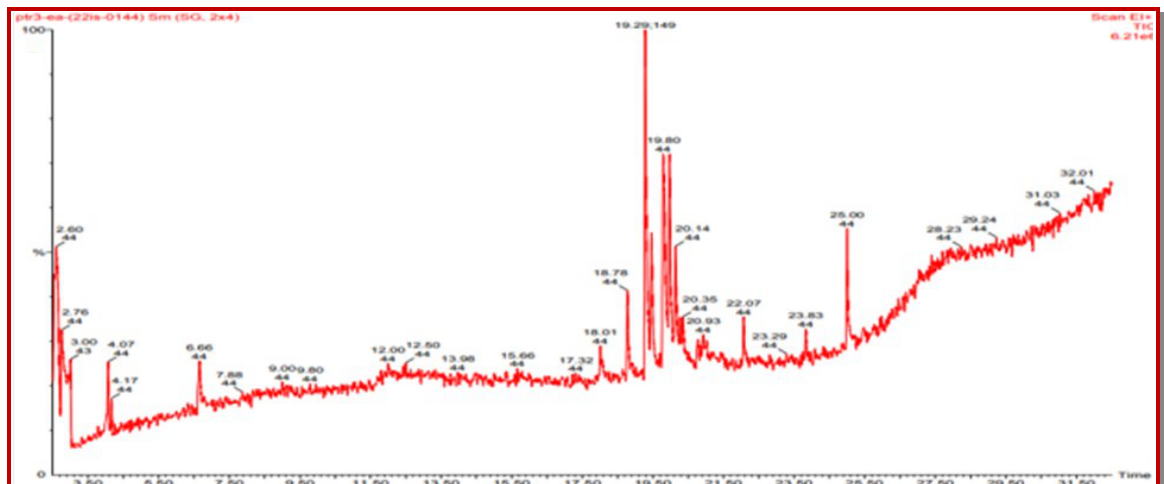
Figure 3: Chromatogram analysis of ethyl acetate